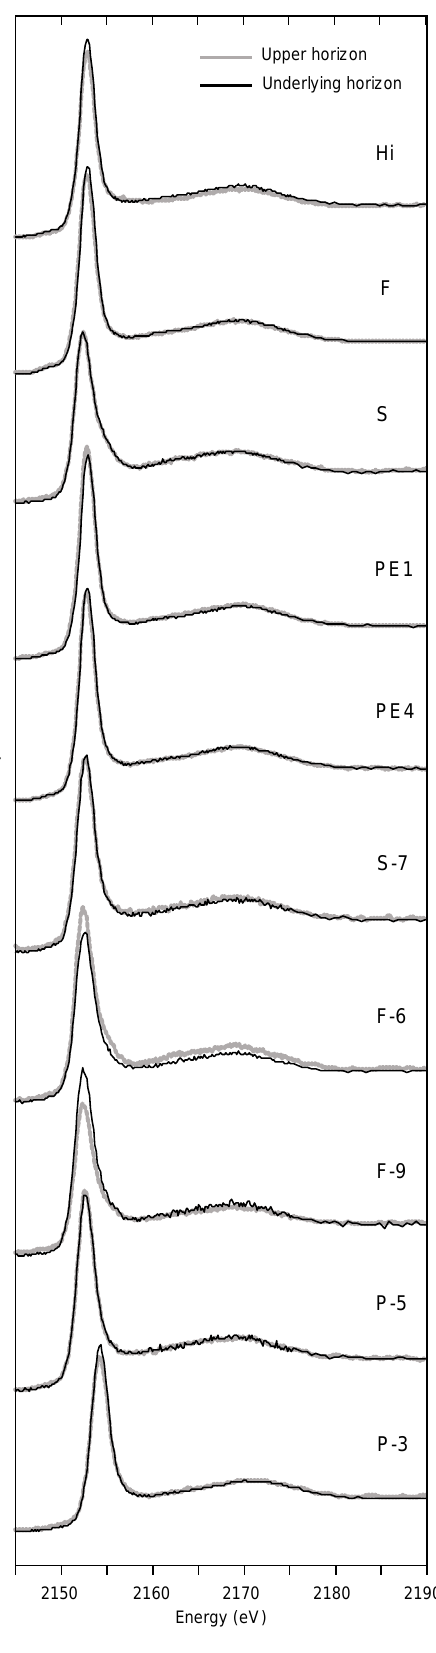
Figure 3. Stacked normalized P K -edge XANES spectra of 10 Northern European Anthrosols (Hi: Hillesland; F: Feøy; S: Sandhåland; PE1: Njærheim; PE4: Årsvoll; S7: Vordingborg; F-6: Großenbrode; F-9: Gahlendorf; P-5, P-3: Niendorf).